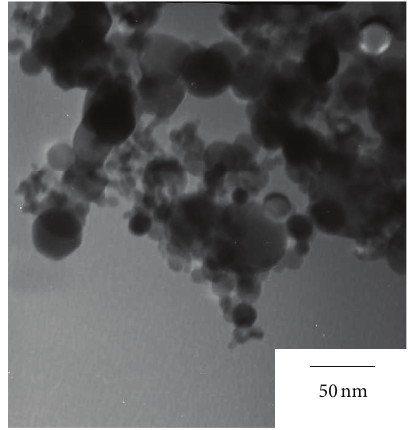
Figure 1: TEM image of the precursor Y 2 O 3